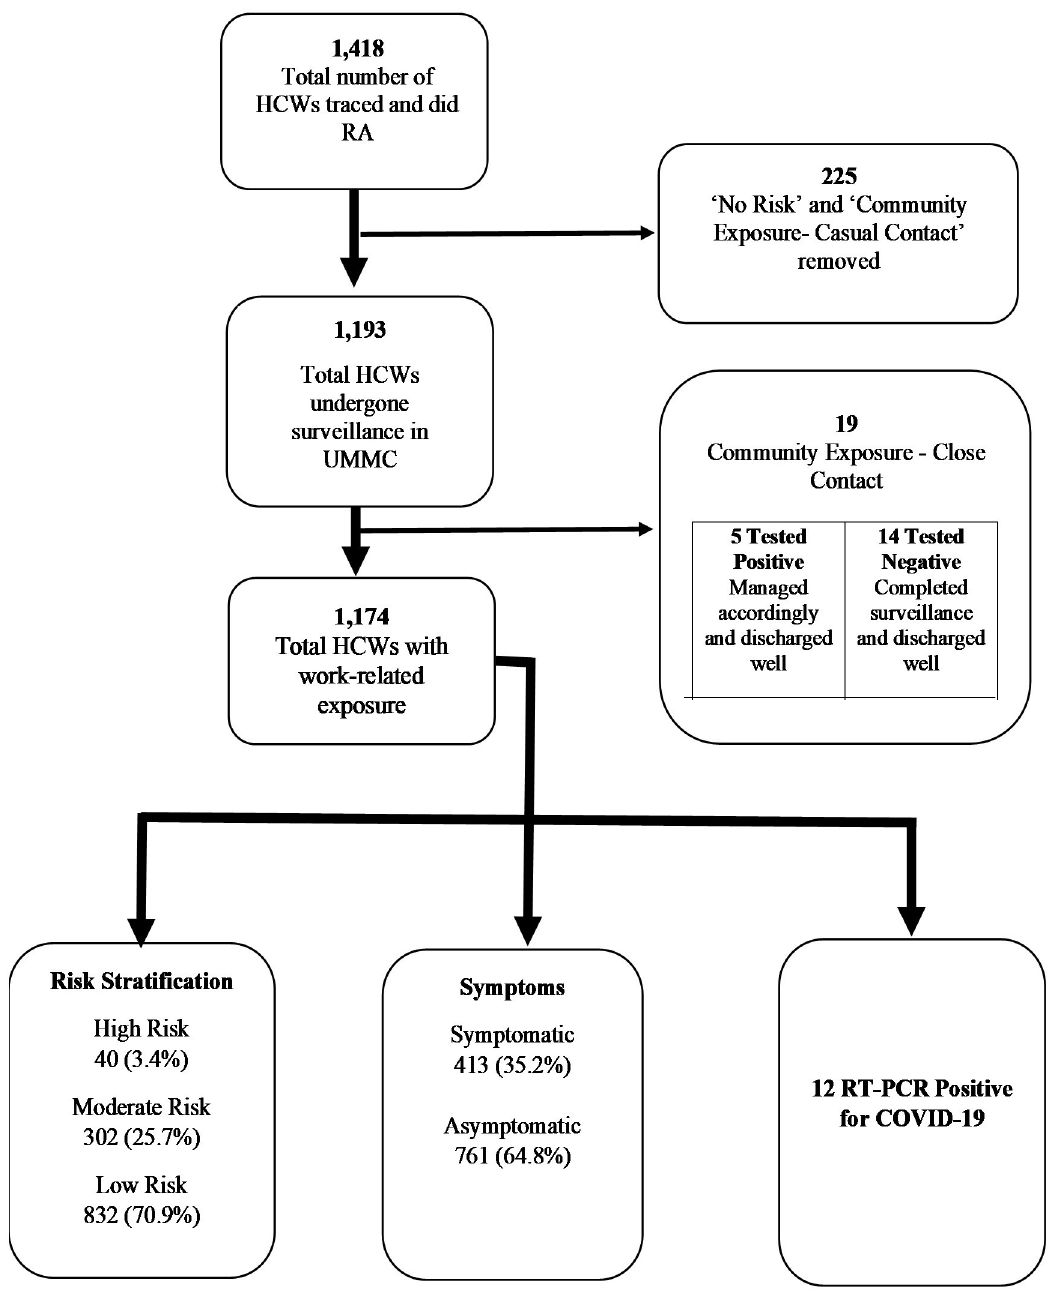
Fig 2. Surveillance flow chart and total HCWs for the study. The surveillance system was only meant for HCWs with work- related exposure. HCWs with community exposure were under the surveillance of the District Health Office. � HCW, healthcare worker; UMMC, University Malaya Medical Centre; RT-PCR, reverse transcriptase-polymerase chain reaction.